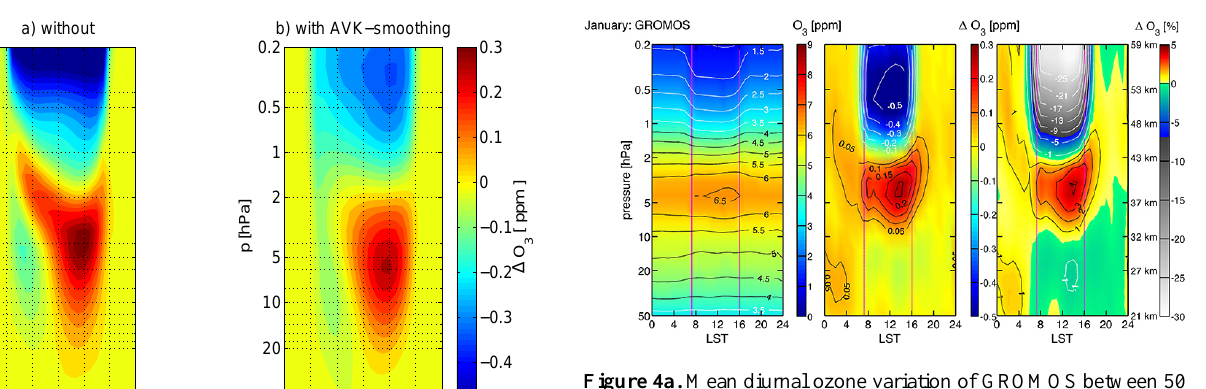
Figure 4a. Mean diurnal ozone variation of GROMOS between 50 and 0.2hPa for January. The averaged data are based on 17years of observations (November 1994 to October 2011). The left panel shows the variation of ozone volume mixing ratio (VMR) as a func- tion of local solar time (LST). The middle panel gives the absolute mean difference 1O 3 , while the right panel shows the relative mean difference 1O 3 in percent. Both absolute and relative mean differ- ences are with respect to the mean nighttime ozone value (22:30– 01:30LST) of January. Magenta lines indicate a solar zenith angle of 90°.